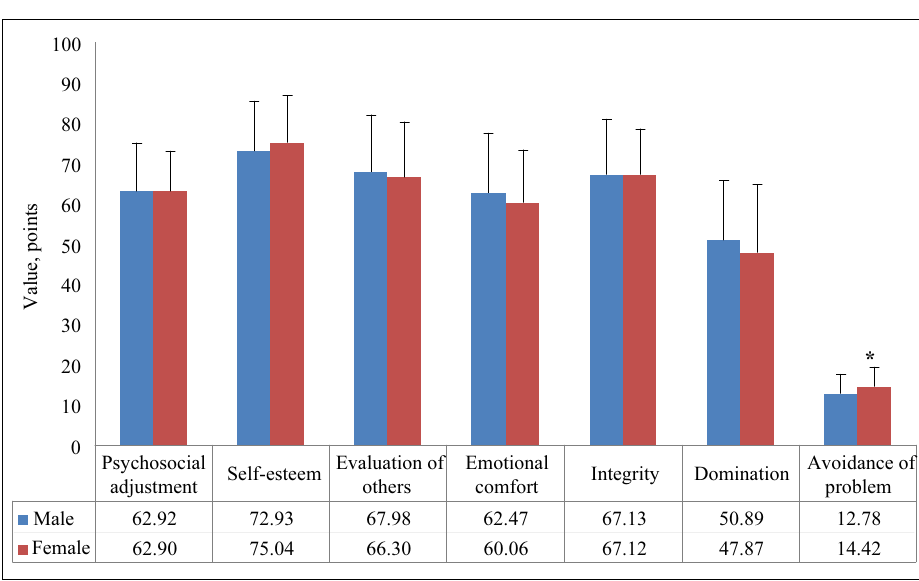
(average in points)